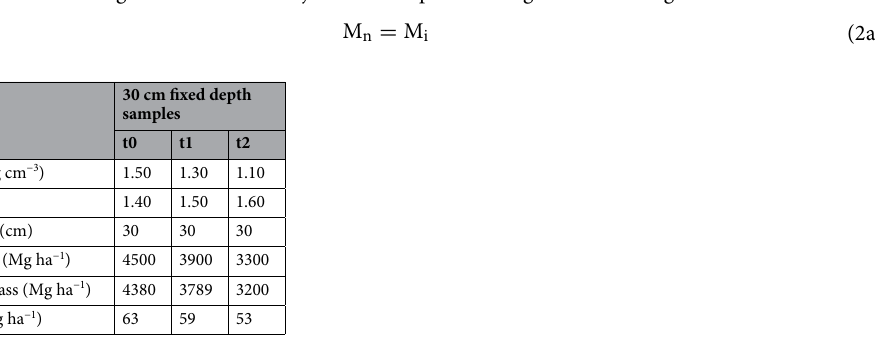
Table 1. Hypothetical changes in bulk density (BD) and soil organic carbon (SOC) concentration in 30 cm fixed depth samples at time points t0, t1 and t2 along with calculated values of SOC stock and total soil mass and mineral soil